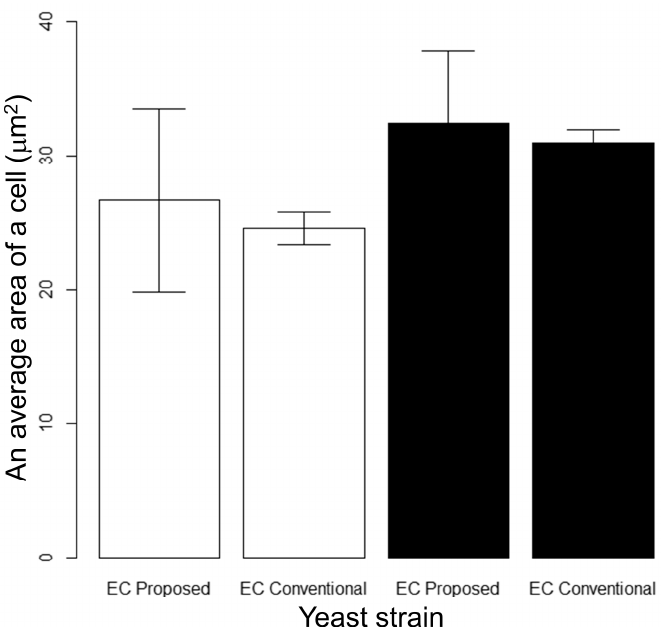
Figure 2. Automatically measured areas using conventional software methods (( right ) EC and BC) and proposed methods (( left ) EC and BC). More than 30 cells are measured for each yeast strain, and the results are presented as means with standard deviations and error bars. The proposed method detected no significant difference between EC and BC ( p = 0.21 > 0.05), whereas the conventional method found a significant difference between the two strains ( p = 2.2 × 10 − 4 <